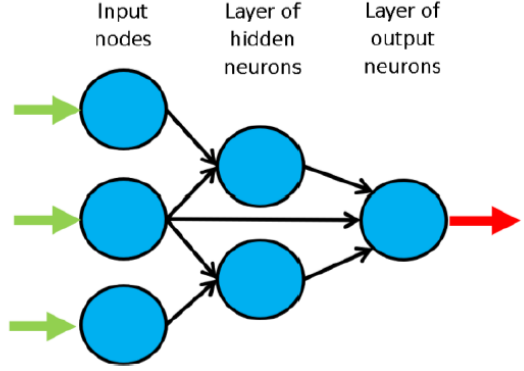
Figure 3. Example of a feed-forward neural network